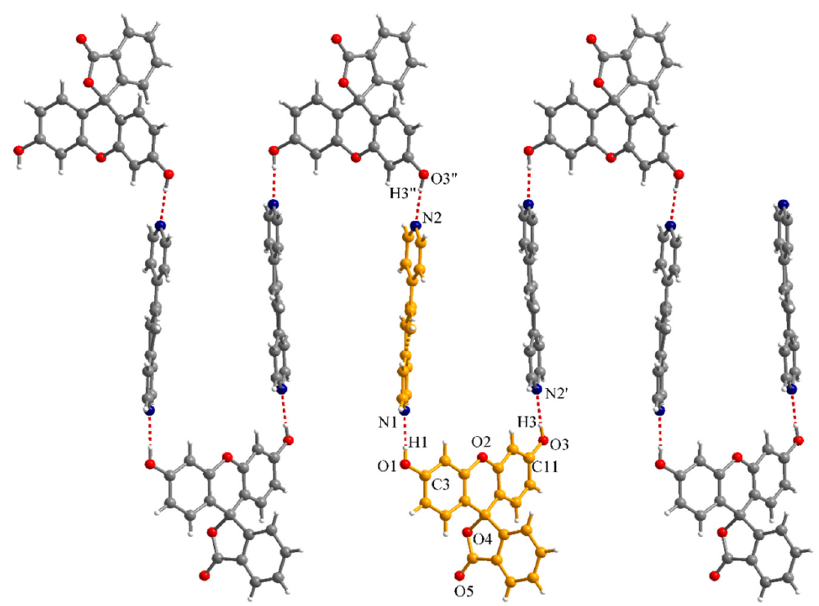
Figure 8. Perspective view of the supramolecular chain formed through hydrogen interactions in crystal 4 . The asymmetric unit is depicted in orange. Symmetry codes: ’ = − x, − 0.5 + y, − 0.5 − z; “ = − x, 0.5 + y, − 0.5 − z.